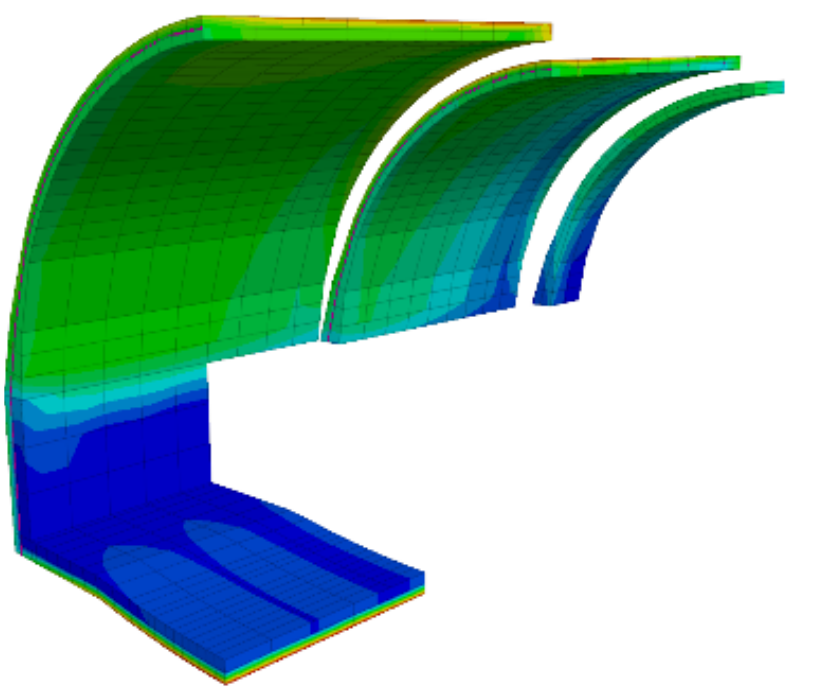
Figure 21. Total displacements (in meters) in the concrete elements. Minimum parameters.